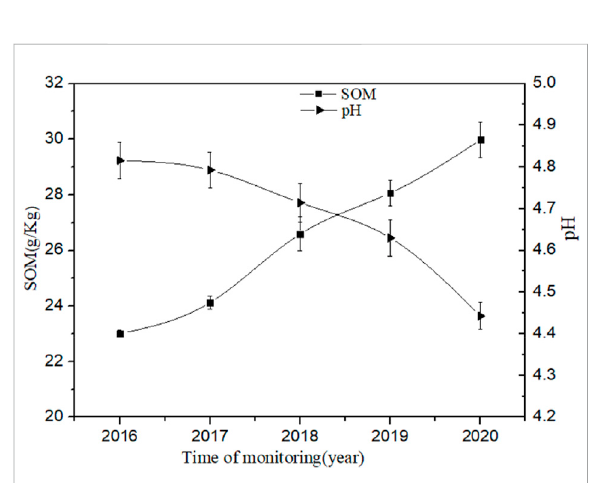
FIGURE 2 Accumulation trend of soil organic matter and the change trend of soil pH with time.